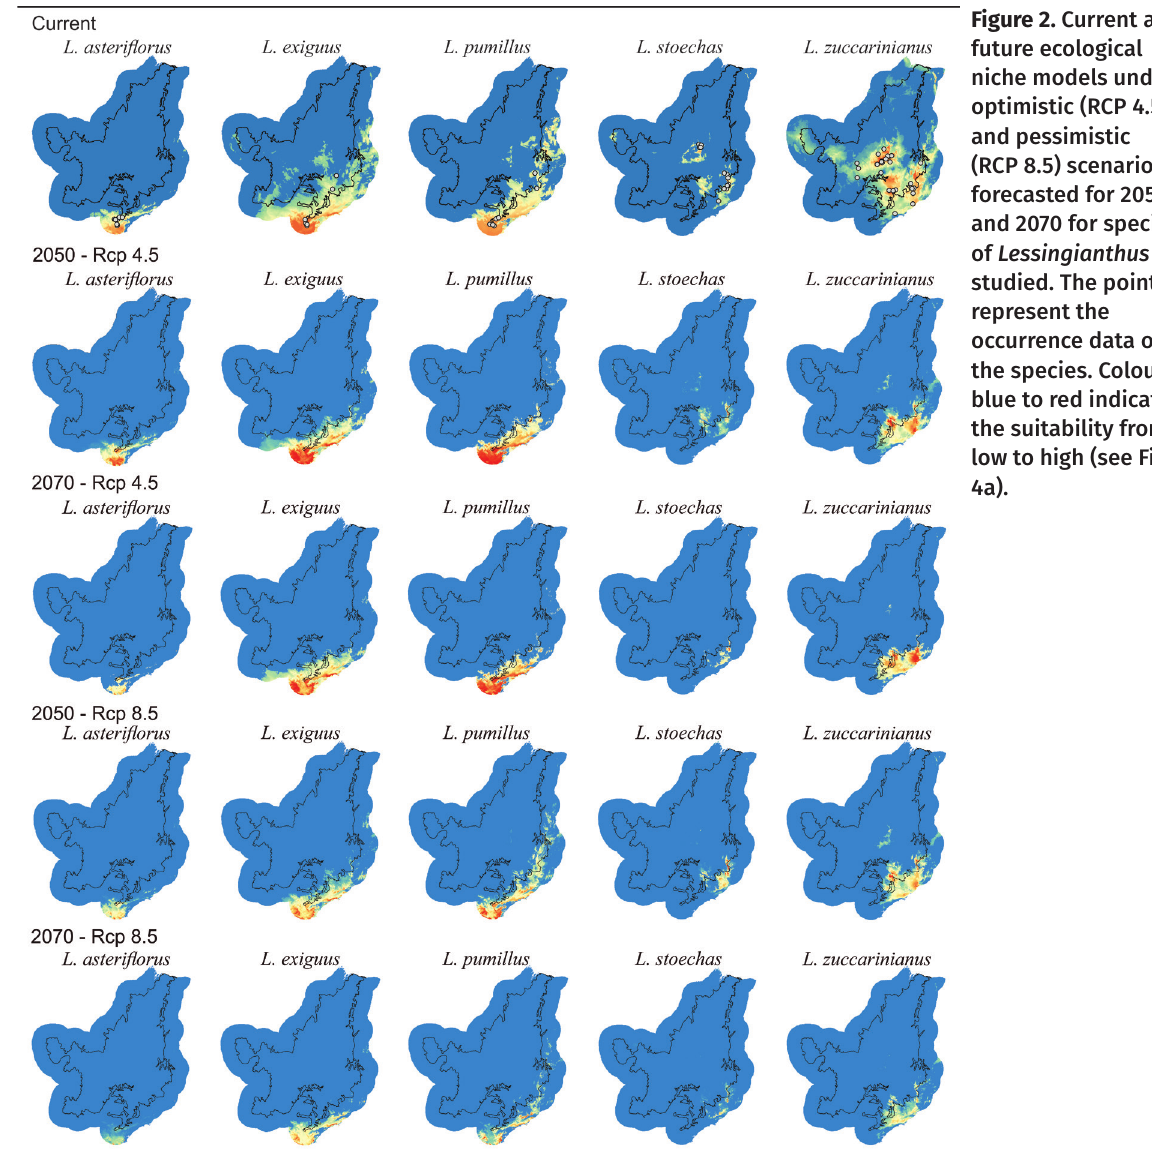
Figure 2. Current and future ecological niche models under optimistic (RCP 4.5) and pessimistic (RCP 8.5) scenarios forecasted for 2050 and 2070 for species of Lessingianthus studied. The points represent the occurrence data of the species. Colour blue to red indicates the suitability from low to high (see Fig.